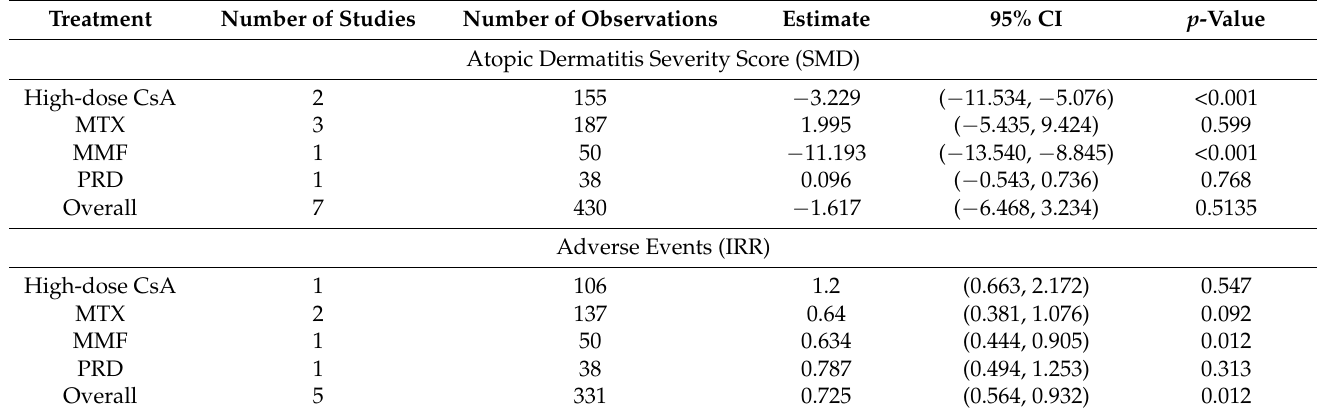
Table 2. Data summary of studies included in the meta-analysis.